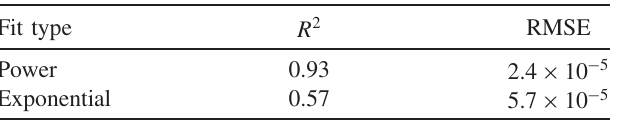
TABLE II. The goodness of fit in the inset of Fig. 13. The R-square value (middle column) and the root-mean-square error (RMSE) (last column) for power-law and exponential fits are provided.